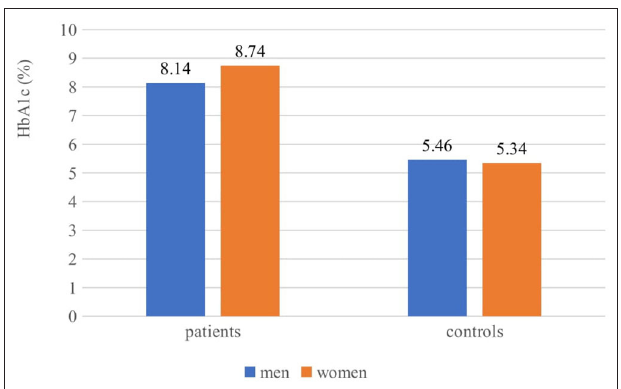
FIGURE 1 | Gender based differences in glycaemic control in patients and